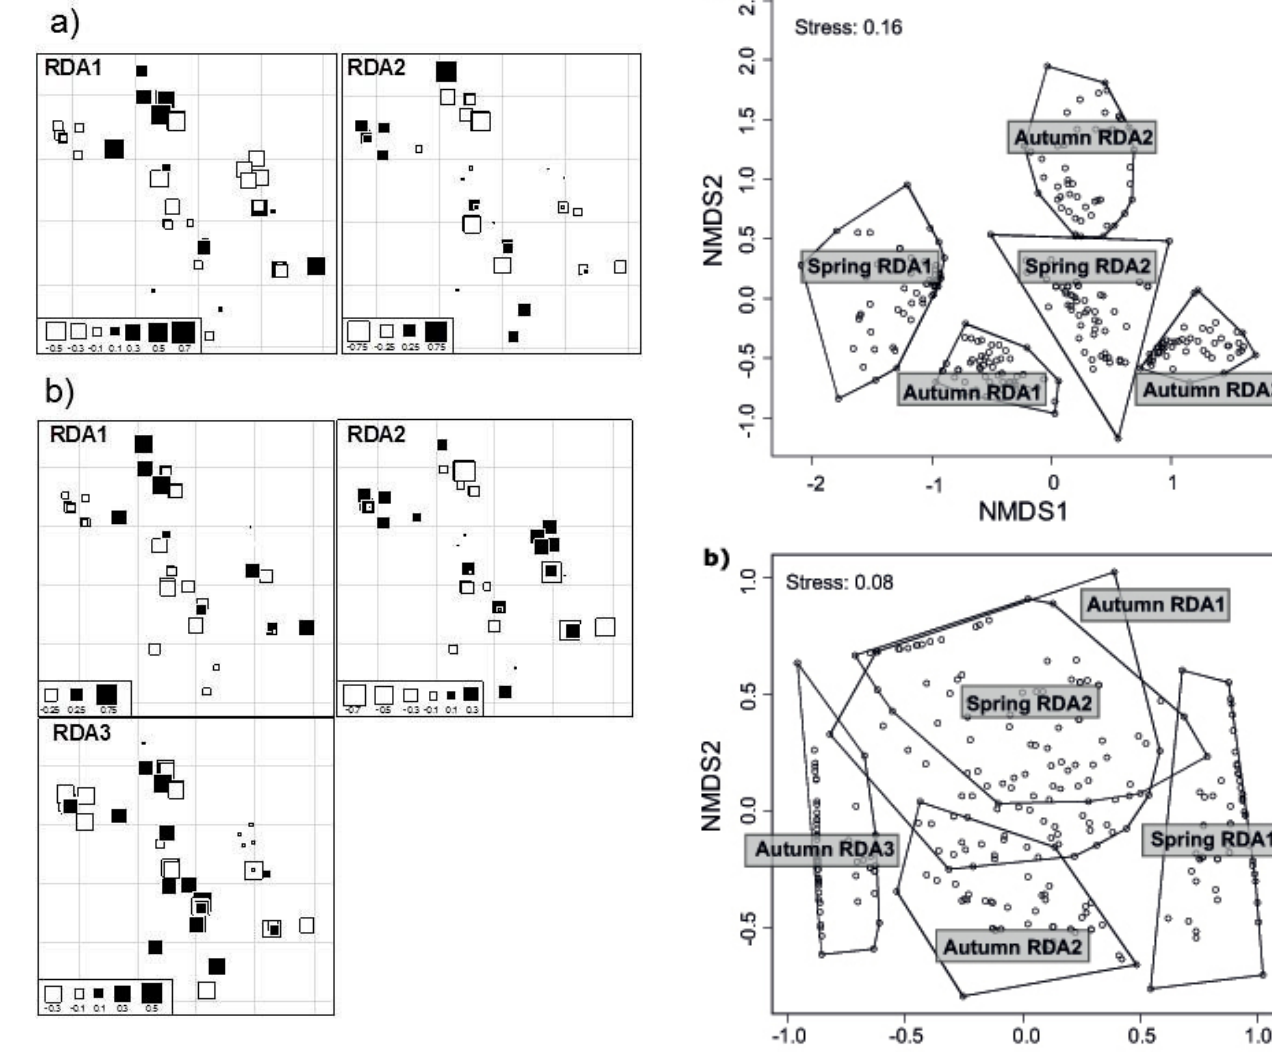
Fig. 3 . Nonmetric multidimensional scaling diagrams showing (a) taxonomic and (b) functional feeding group composition across and within the different spatial scales (RDA1, RDA2, RDA3) identified through principal coordinates of neighbor matrices analysis and between the two seasons (spring and autumn). The analysis is based on Bray-Curtis dissimilarities and n = 52 in all defined